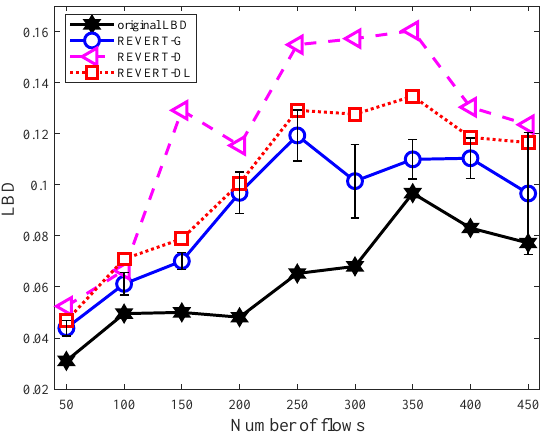
Figure 9. Comparison of load balancing